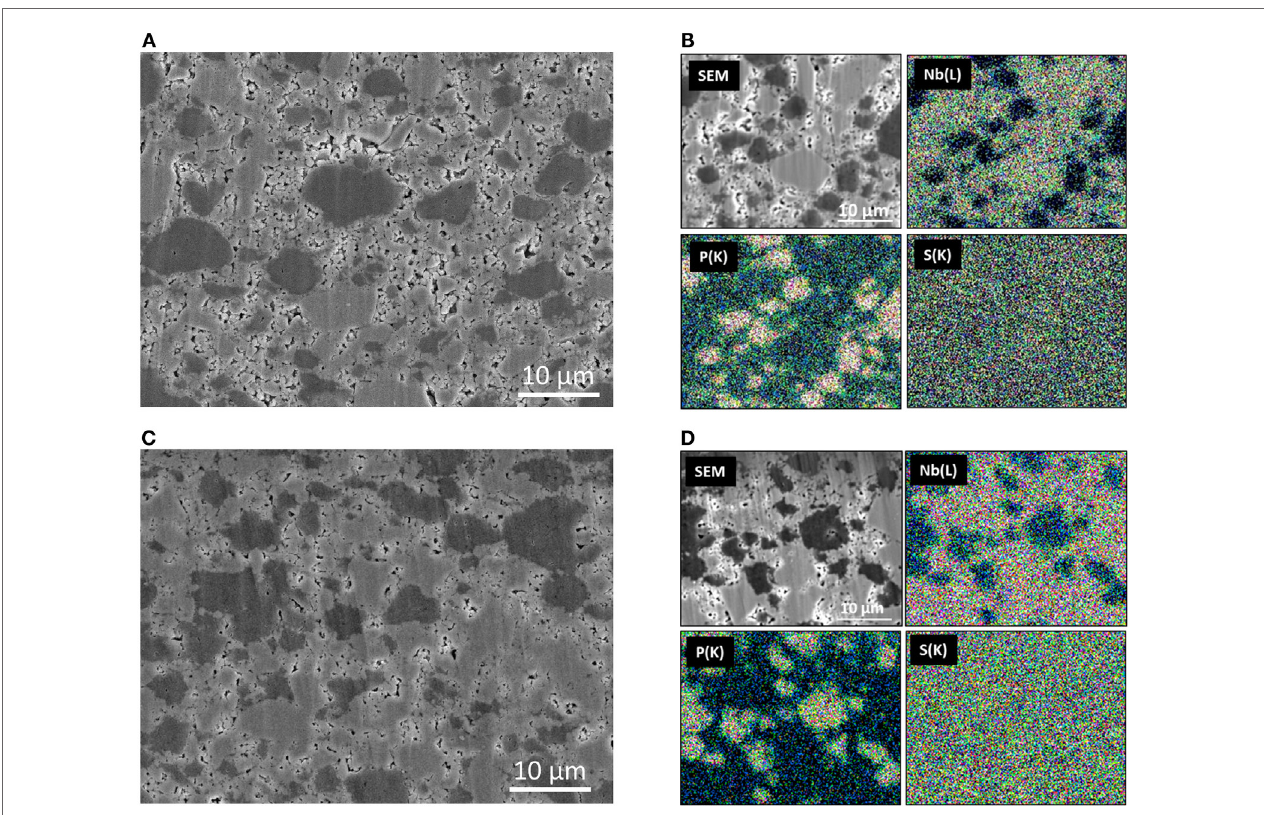
FigUre 6 | cross-sectional seM images of the composite electrode of the all-solid-state cell after the first charging (a) and discharging (B) . The EDX mappings for Nb–L, P–K, and S–K of the cross-sections of the composite electrode after first charging (c) and discharging (D) are also shown.